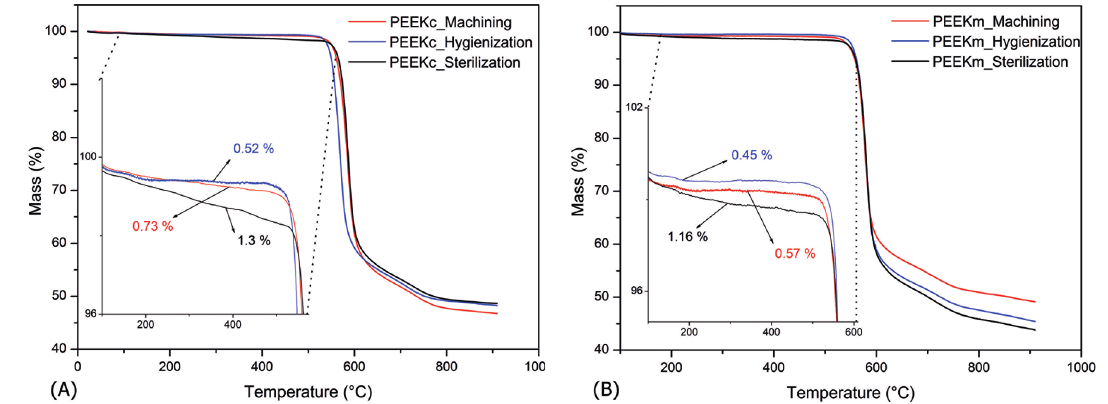
Figure 1: TGA curves after machining, hygienization and sterilization process stages: (A) PEEKc and (B) PEEKm.